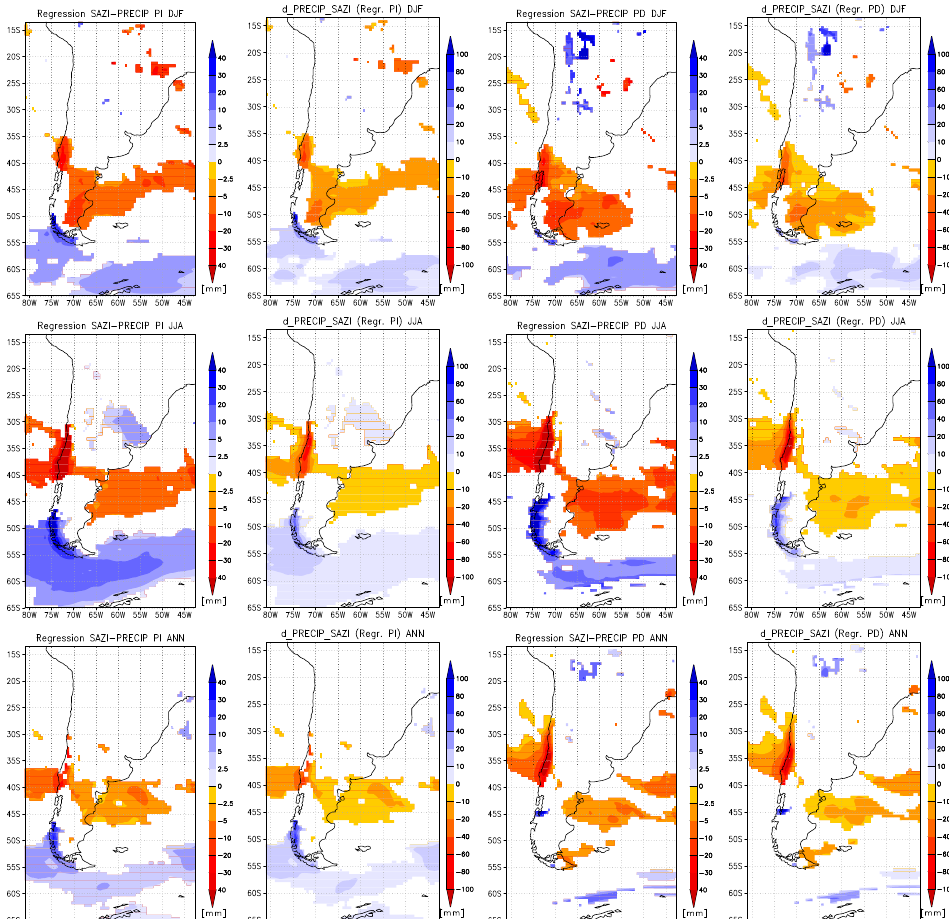
Fig. 9. Same as Fig. 8 except for Figure 9 : Same as Fig. 8 except for precipitation.